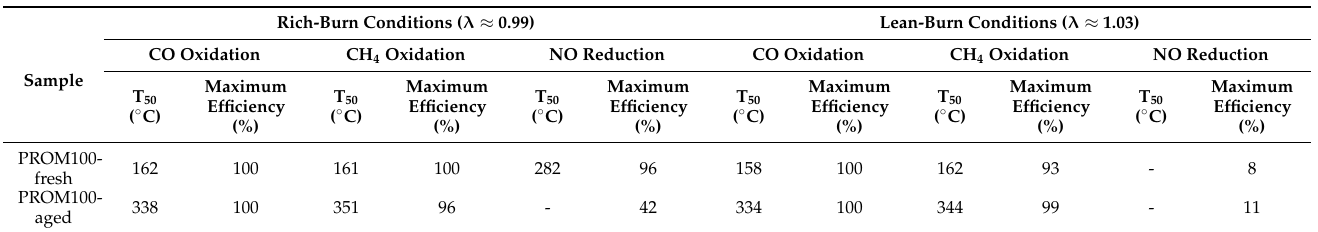
Figure 9. Light-off curves of the conversion of CO, CH 4 and NO of PROM100-fresh catalytic washcoat: ( A ) under rich-burn conditions ( λ = 0.99) and ( B ) under lean-burn conditions ( λ = 1.03). Table 4. T50 and maximum efficiency values for the abatement of CO, CH4 and NO, obtained for the tested